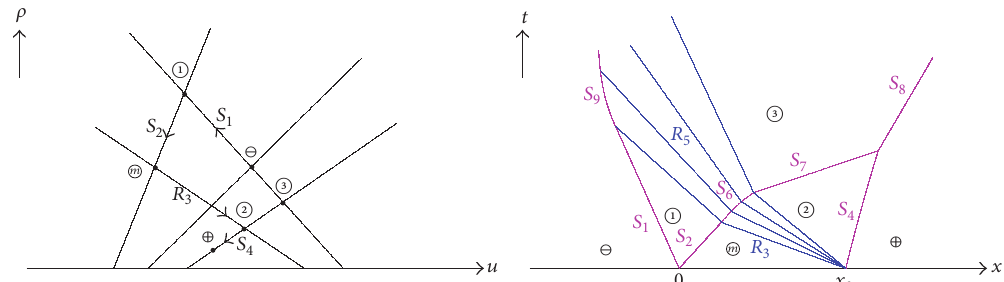
Figure 6: The interaction between 𝑆 + 𝑆 and 𝑅 + 𝑆 is shown when (𝑢 + ,𝜌 + ) ∈ 𝑉 5 .